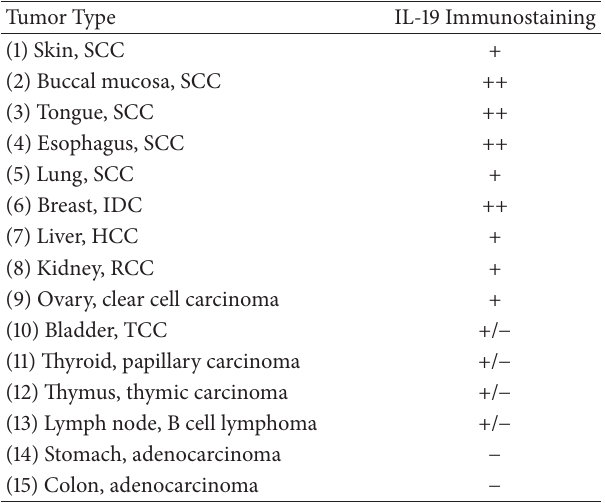
Table 1: Tumor cells stained for IL-19 in neoplastic